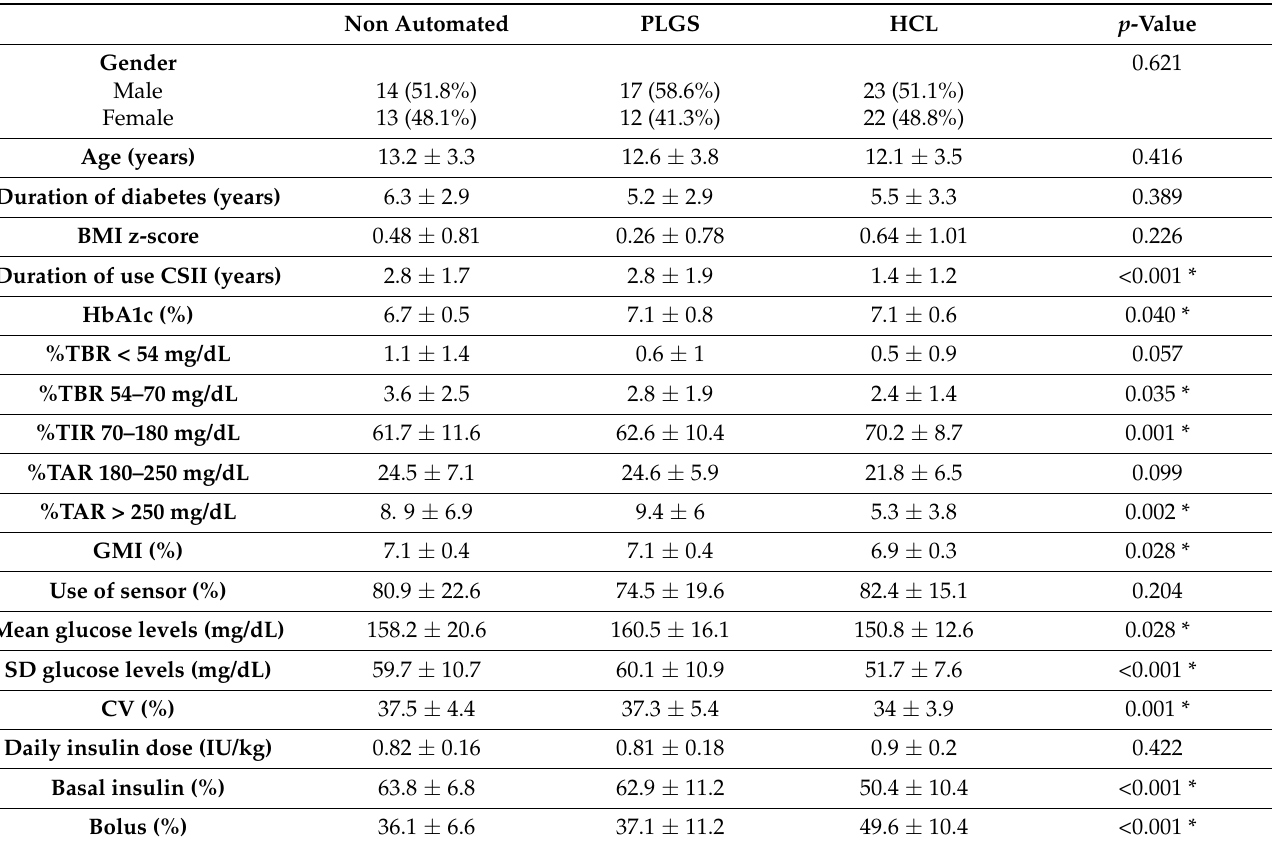
Table 1. Comparison of anthropometric and clinical data among patients with different CSII systems. Indicators of glycemic control are expressed as the mean and standard deviation of the aggregated data of each quarterly follow-up